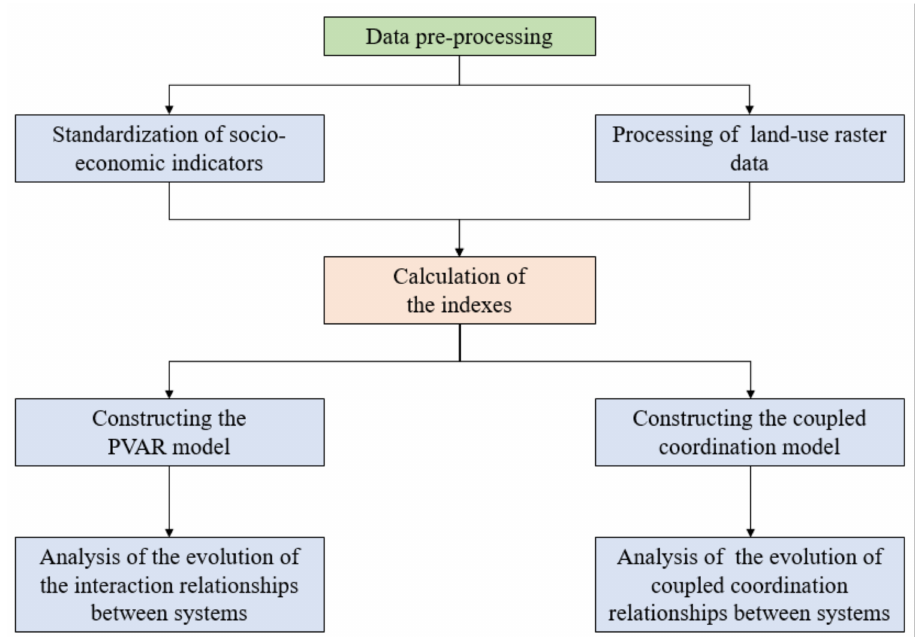
Figure 2. The process of data